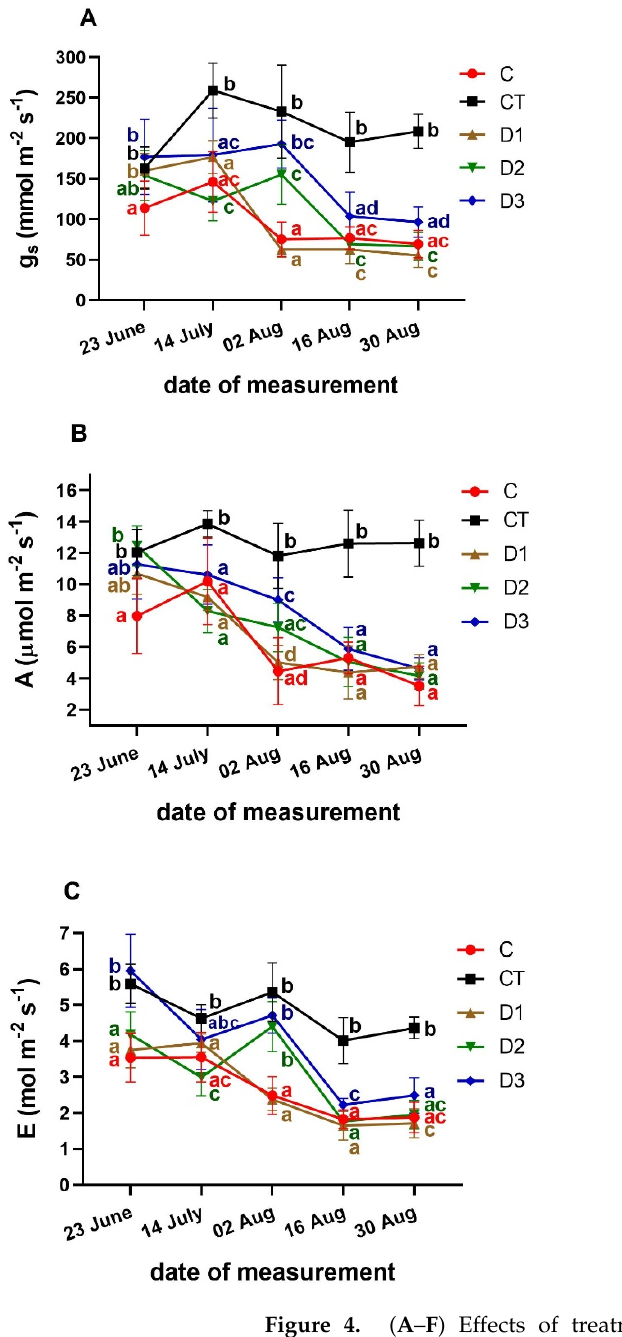
Table 1. Results of the correlation analysis between mean stomatal conductance ( g s ) and leaf assim- ilation rate ( A ) data or leaf transpiration rate ( E ) data in the case of each treatment, variety, and year, with 5-5 measurement dates/year. Asterisks mark the significance of differences (* p < 0.05, ** p < 0.005), ns: not significant.